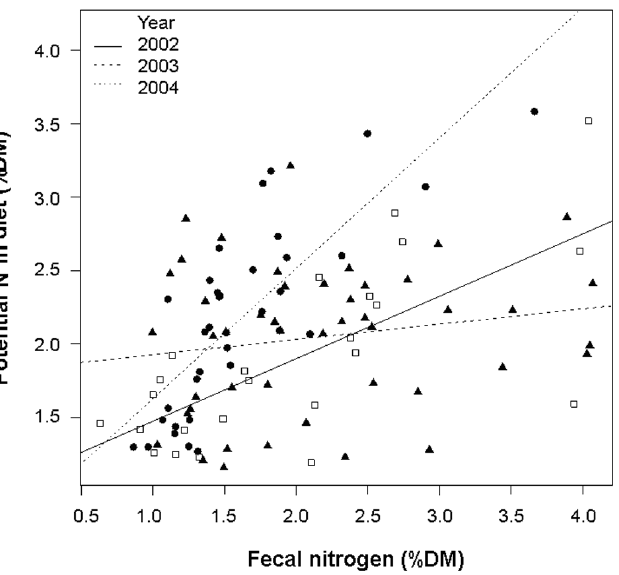
Fig 4. Relationship between potential dietary N and faecal N of Pyrenean Rock Ptarmigan (ANCOVA plot) split by year (2002, 2003 and 2004). Data are expressed in percentage of dry matter (%DM). Empty squares: samples from 2002; black triangles: 2003, and black circles: 2004. See Table 1 for ANCOVA results.